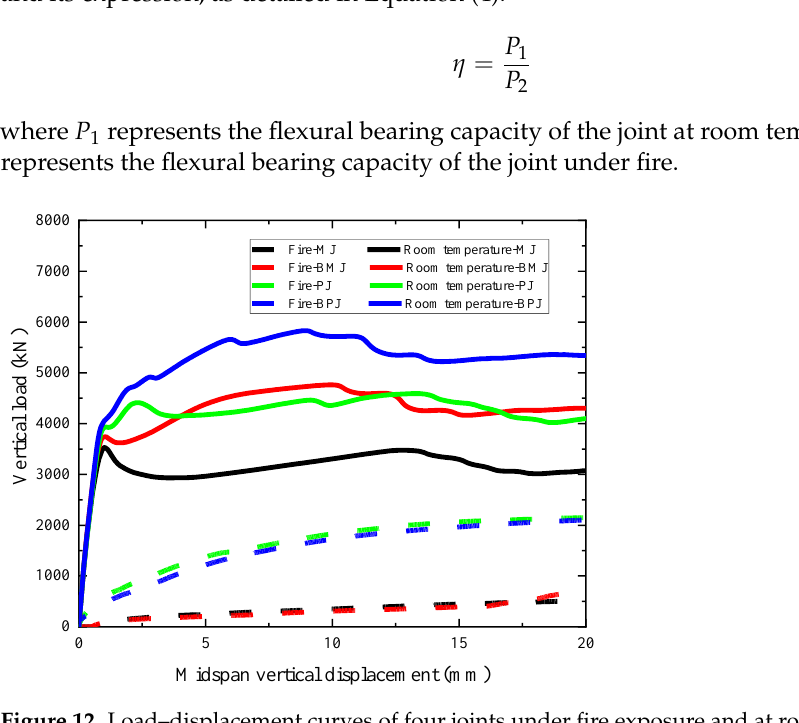
Figure 13. Flexural bearing capacity of four joints under a fire of 120 min and at room tempera- ture. 3.4. Opening Structural deformation is the primary reference for judging the limited state of a structure. In this study, the opening outside of the joint is used as the index to judge struc- tural deformation. To compare the deformation characteristics of the four types of joints under fire, a 500 kN axial force and the standard European HC curve of 120 min are ap- plied to the joint. The opening of the upper edge of the joint is extracted, and the relation- ship curve of the opening with time is obtained, as shown in Figure 14. Figure 14 shows that the openings of the four types of joints increase rapidly from 0 to 10 min and then slowly increase. Among them, the MJ and BMJ have basically the same variation in the opening from 0 to 5 min, and the change rate of the opening is greater than that of the other two joints. Under a fire of 120 min, the openings of the MJ, BMJ, PJ, and BPJ are 46 mm, 37 mm, 30 mm, and 19 mm, respectively. During the 120 min fire, the opening of the